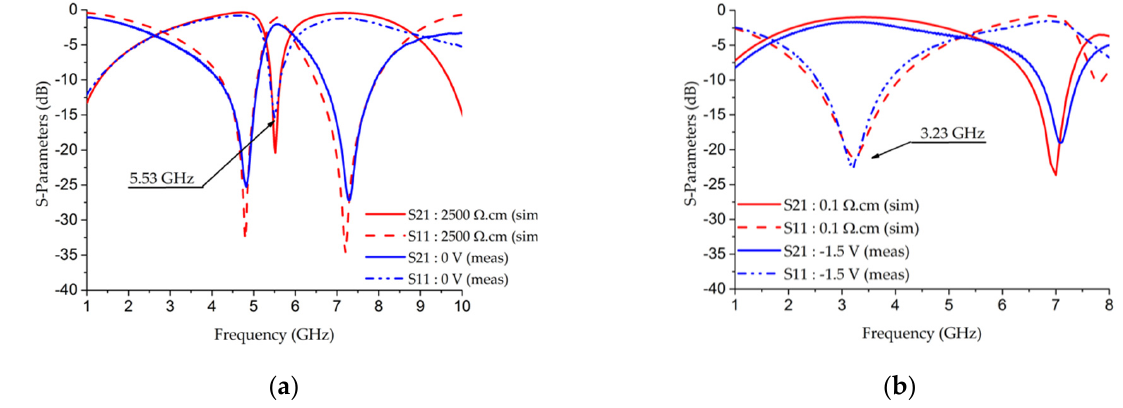
Figure 11. Comparison of simulated and measured results of switchable DBR 3 . ( a ) in the OFF state; ( b ) in the ON state.